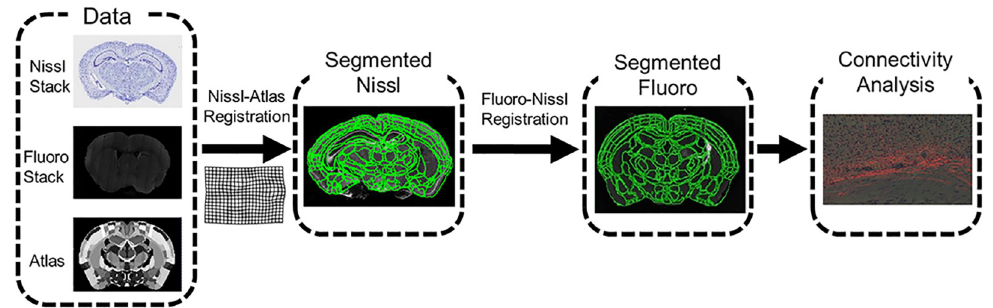
Fig 2. Histology registration pipeline workflow. The pipeline begins with an atlas volume and target sections, proceeds through nissl-to-atlas mapping following by fluoro-to-nissl mapping, and ends with connectivity analysis.